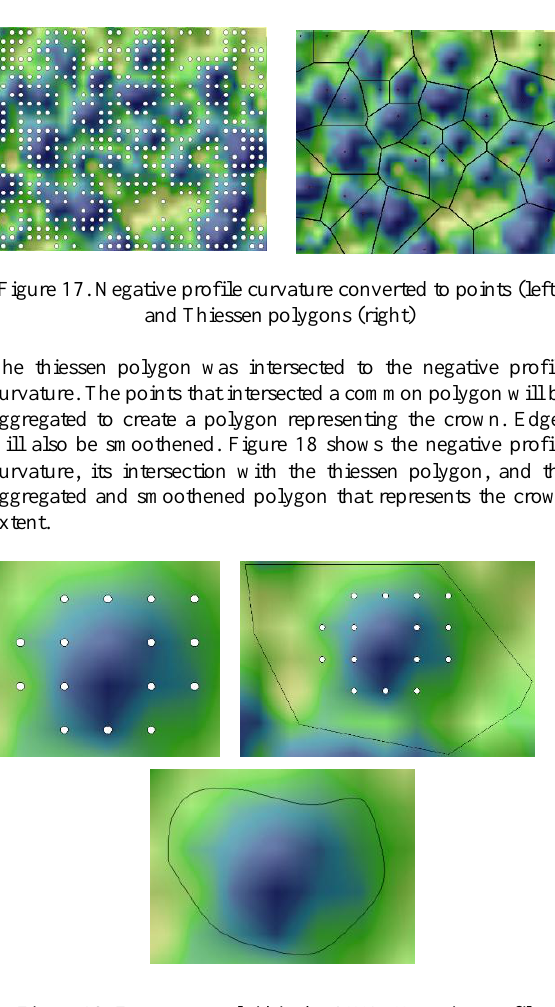
Figure 18. Features overlaid in the CHM: Negative profile curvature (left), intersected thiessen polygon (right), final crown extent (bottom).